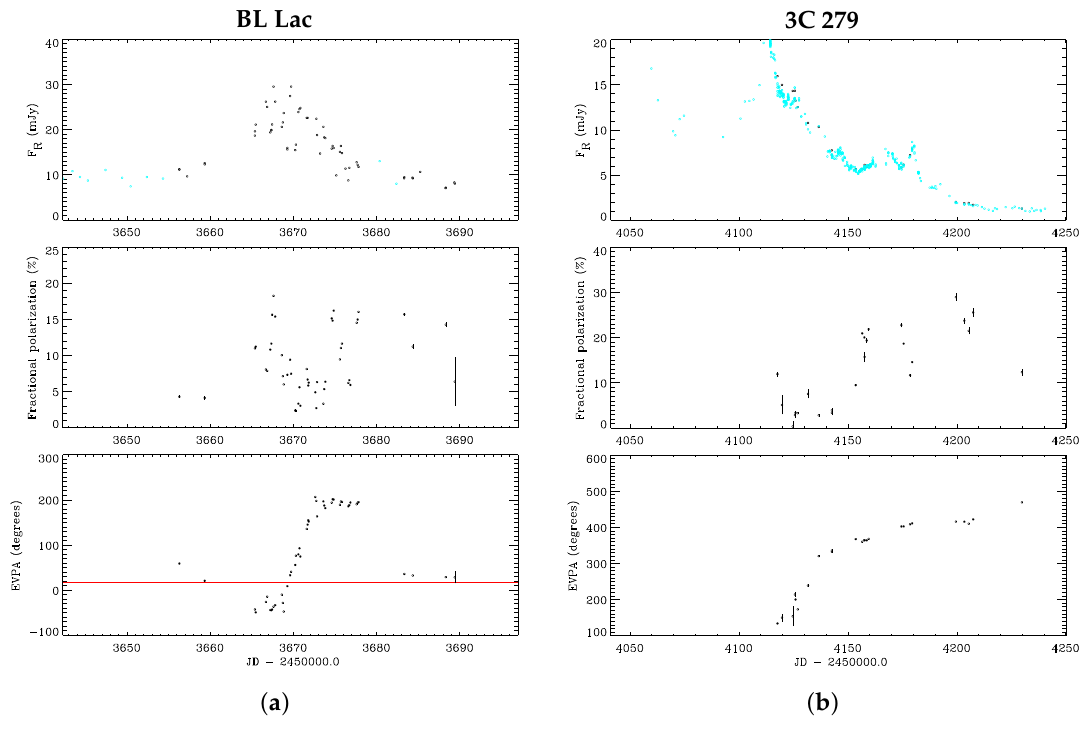
Figure 1. ( a ) From top to bottom: optical R-band brightness evolution, optical fractional polarization, and position angle of polarization for BL Lac during the outburst of October 2005 [1]; ( b ) The same for 3C 279 outburst of January 2007